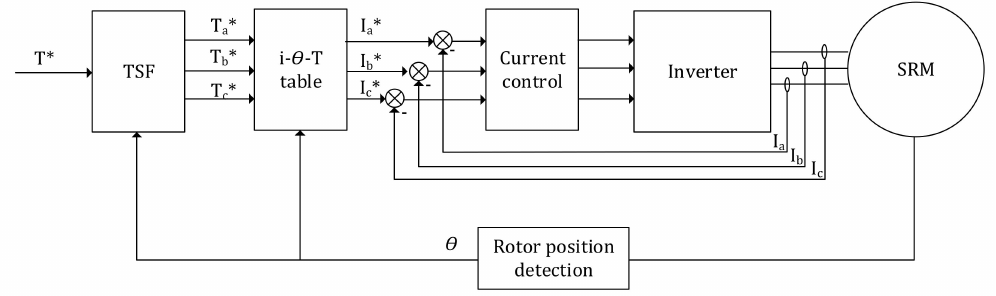
Figure 16. Block diagram of a typical SRM torque control